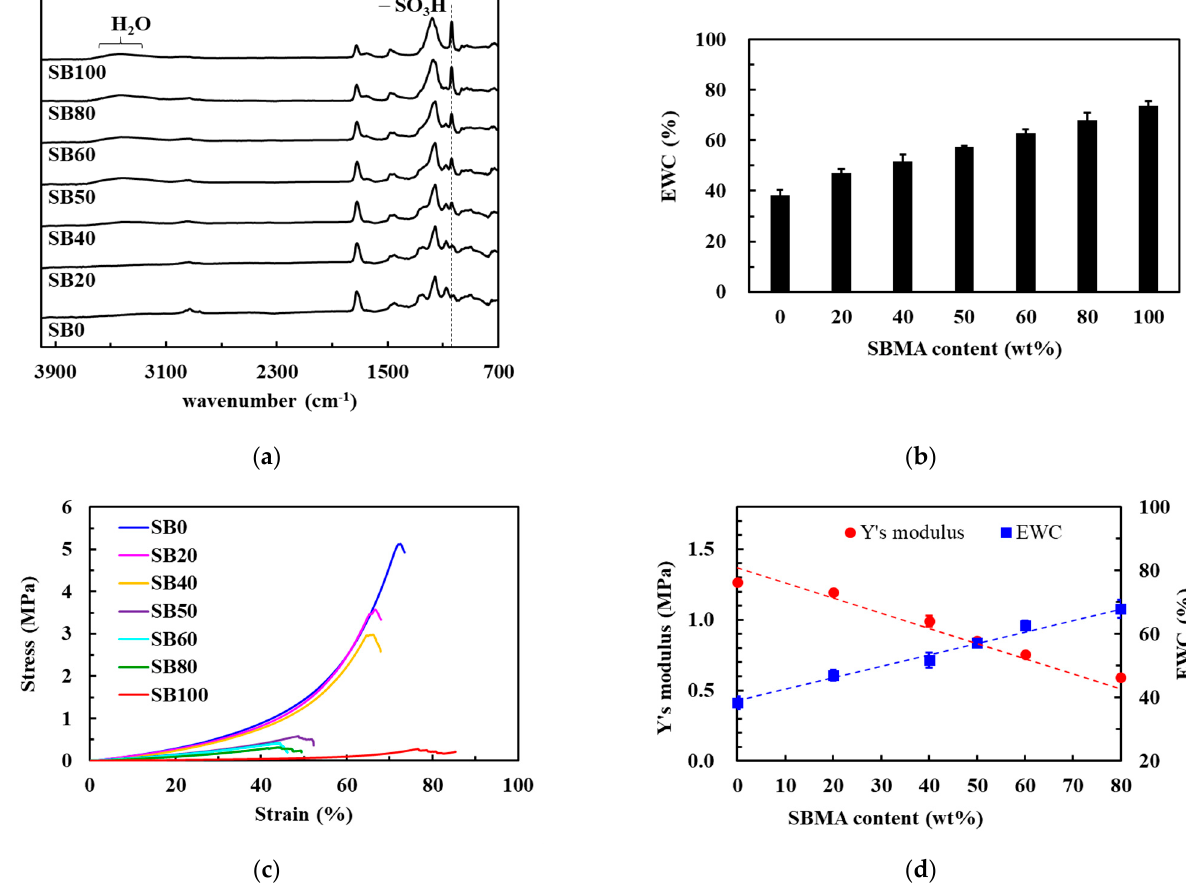
Figure 2. Preparation of hybrid HEMA/SBMA hydrogels. ( a ) FTIR analysis of the hybrid hydrogels. ( b ) The percentage of EWC as a function of the SBMA ratio in the hybrid hydrogels. ( c ) The stress-strain curves for the hybrid hydrogels with various ratios of SBMA. ( d ) Young’s moduli and EWC values for the hybrid hydrogels with various ratios of SBMA. Value = mean ± standard deviation, n = 5.